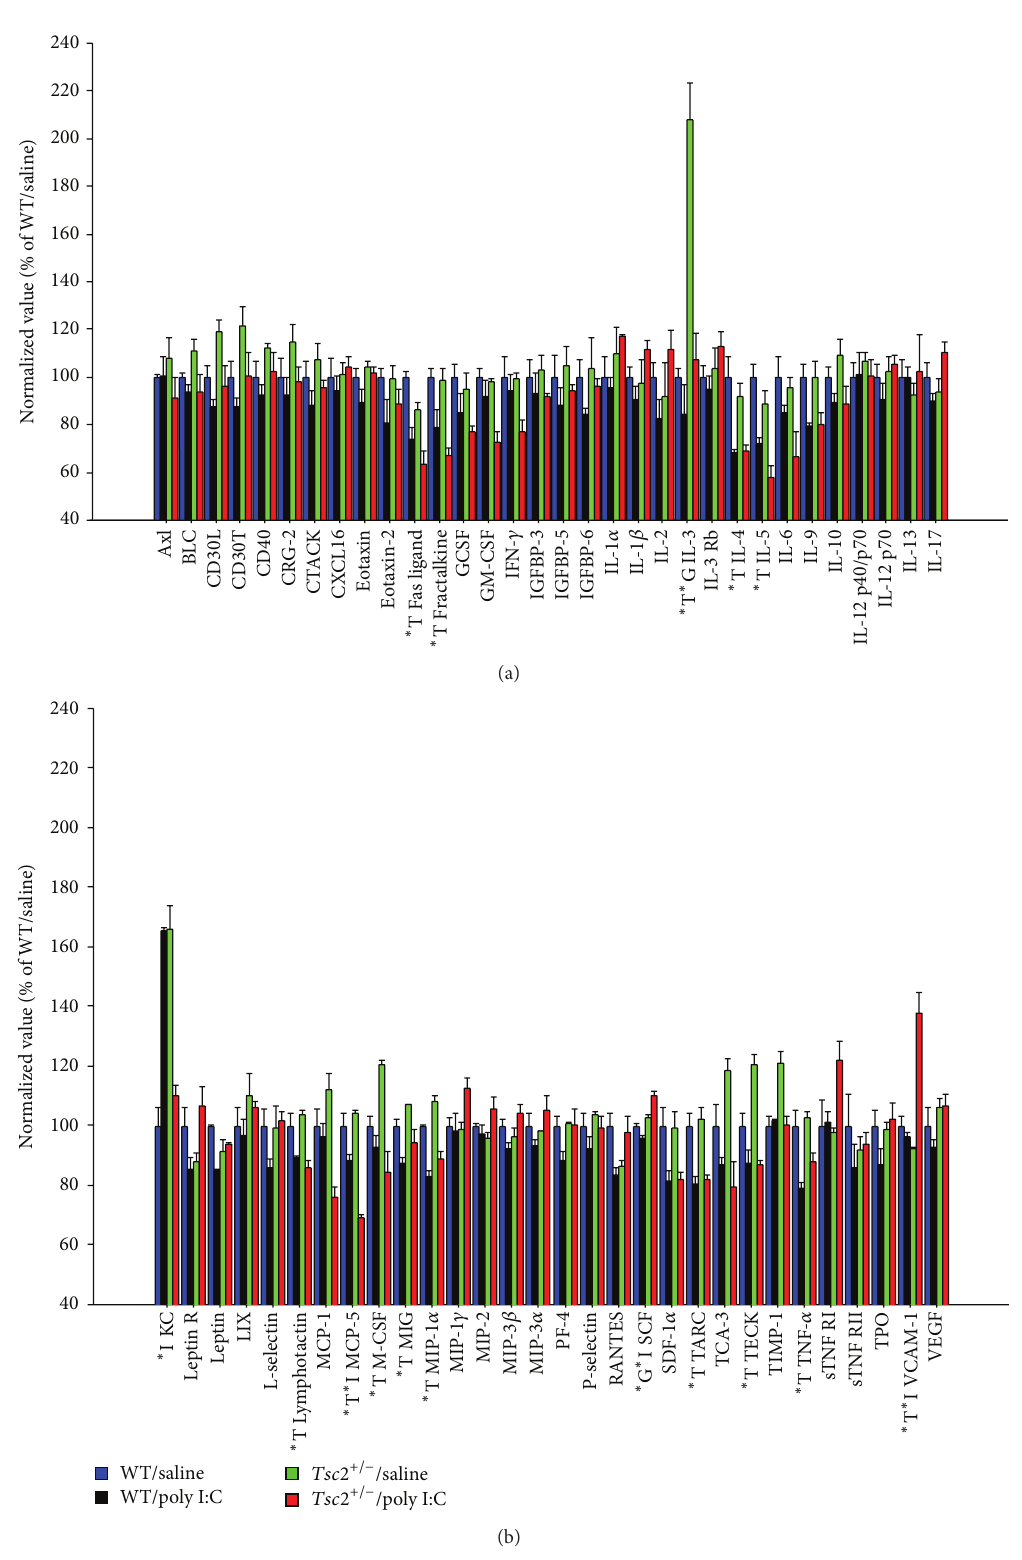
Figure 2: (a) and (b) The figure shows relative cytokine abundances as measured by cytokine antibody arrays in fetal brain at 2 h after gestational poly I:C. Individual cytokines with a main effect of treatment ( ∗ T; 𝑃 < 0.01 ), genotype ( ∗ G; 𝑃 < 0.01 ), or a genotype x treatment interaction ( ∗ I; 𝑃 < 0.01 ) are highlighted. Shown are means +/ −